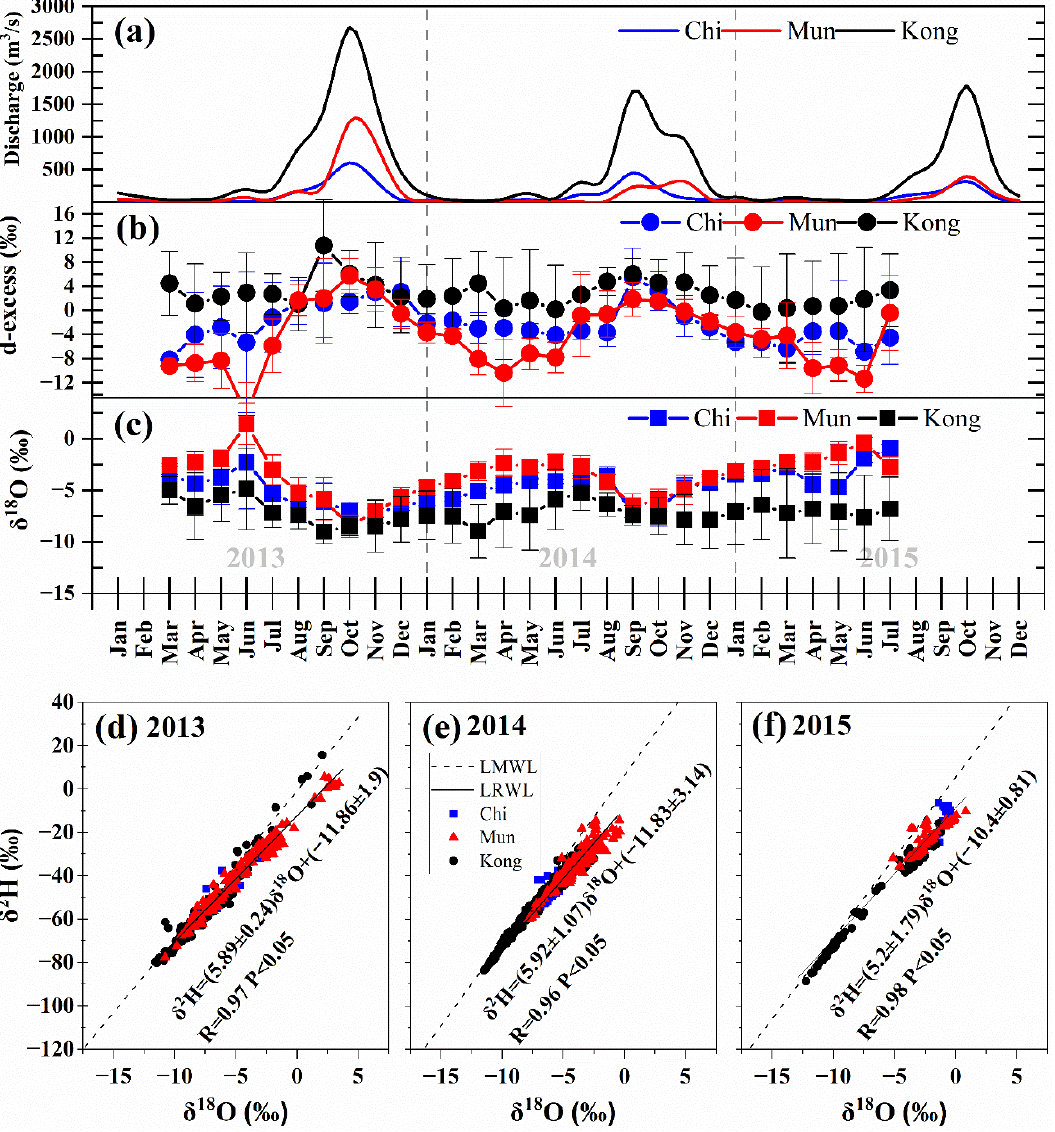
Figure 4. ( a ) River discharge (m 3 /s). ( b , c ) Monthly river isotope. ( d – f ) LRWL.